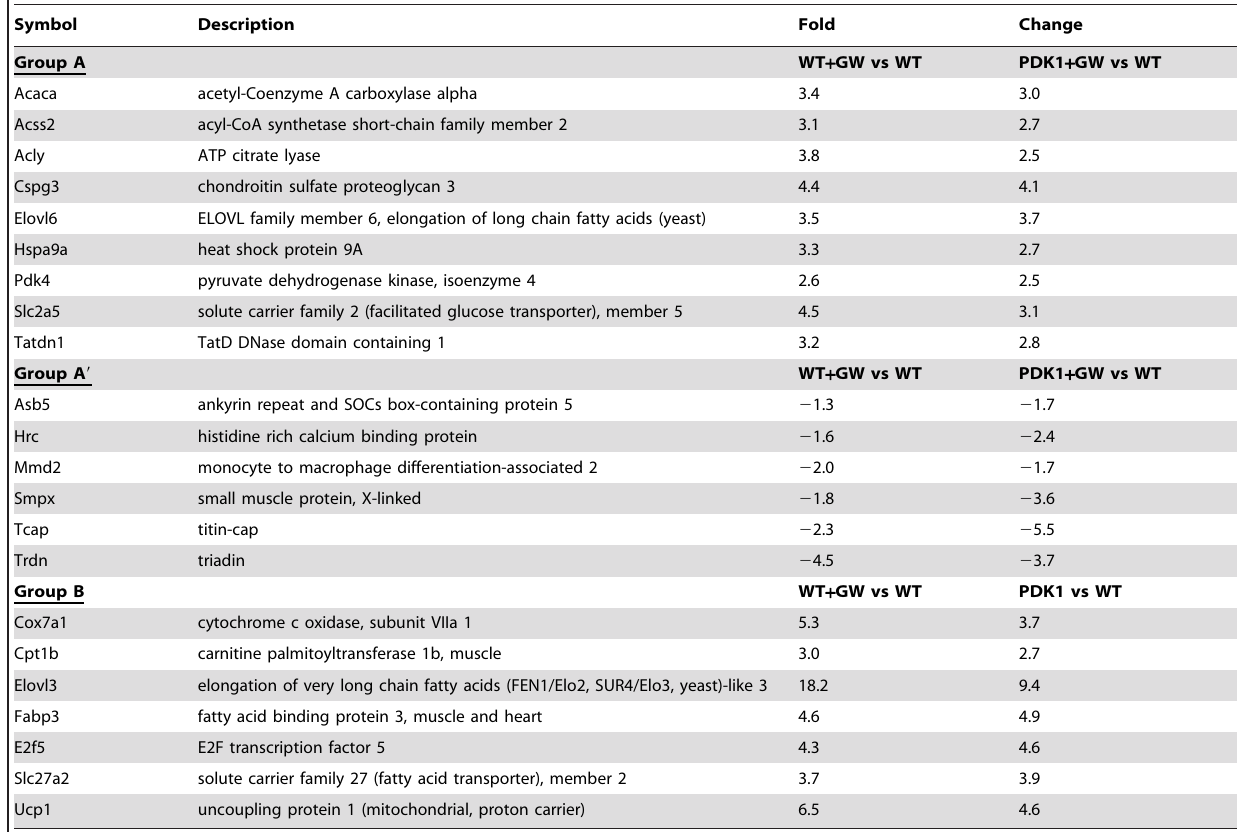
Table 2. Gene microarray analysis: heatmap